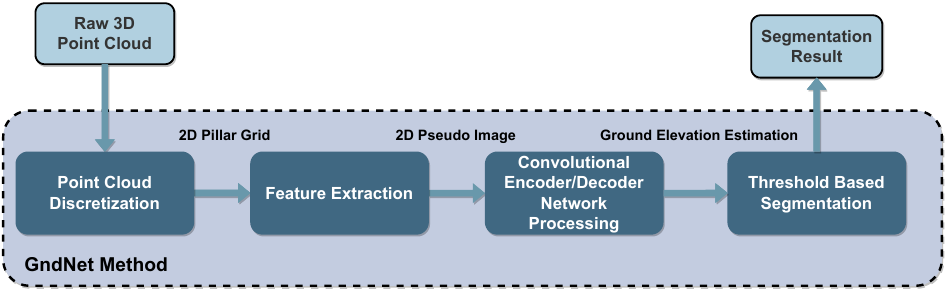
Figure 16. Overview of the GndNet